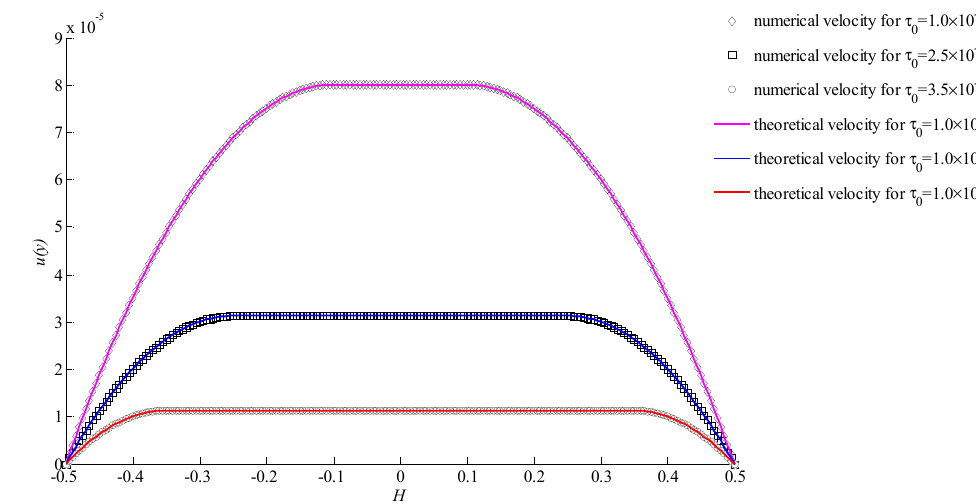
Figure 7. Velocities for n = 1 with different initial yielding stresses.